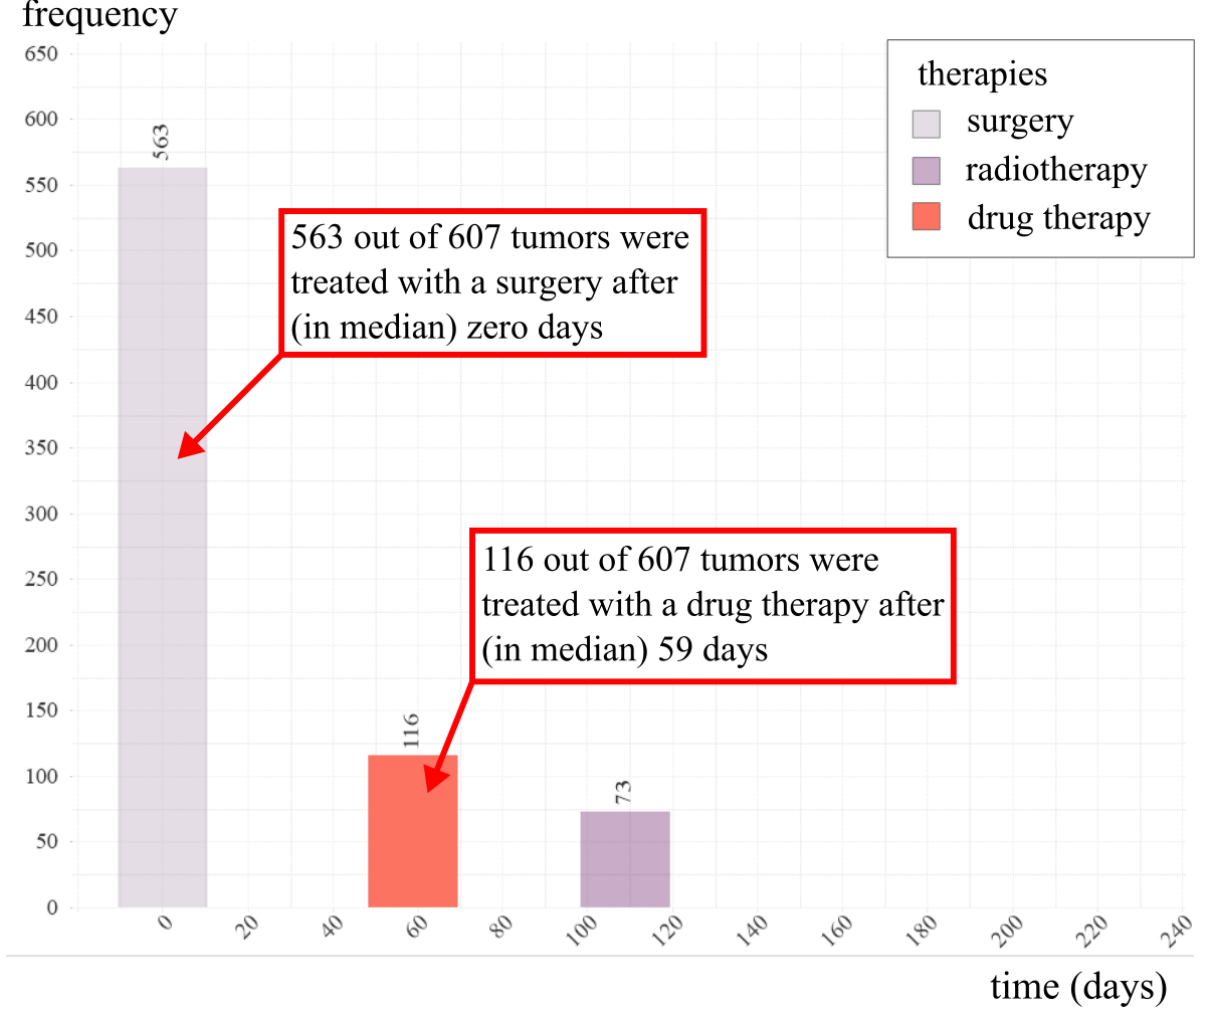
Figure 4. Median start at which a tumor of a chosen cohort has been treated with a specific therapy. The x-axis shows the time (in days), while the y-axis displays how many tumors have been treated in this cohort. In this example, for a cohort of 607 tumors, 563 have been treated with surgery (median after zero days), 116 with drug therapy (median after 59 days), and 73 with radiotherapy (median after 109